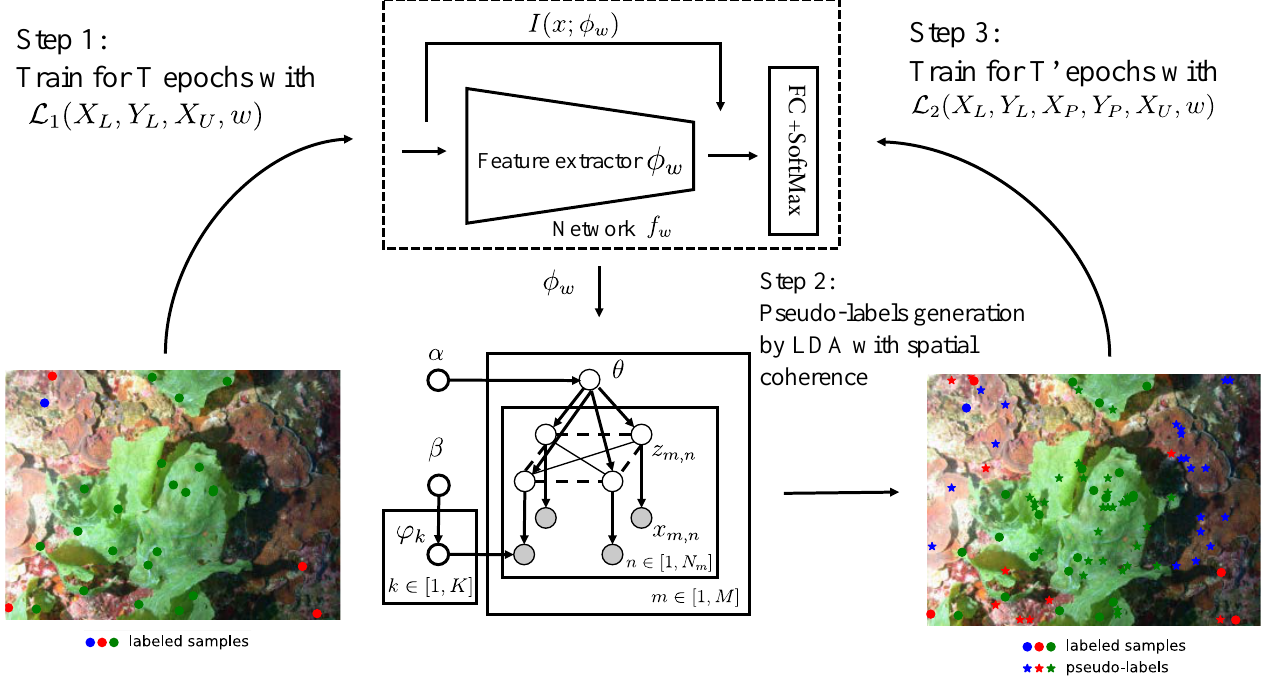
Figure 2. Framework of the proposed